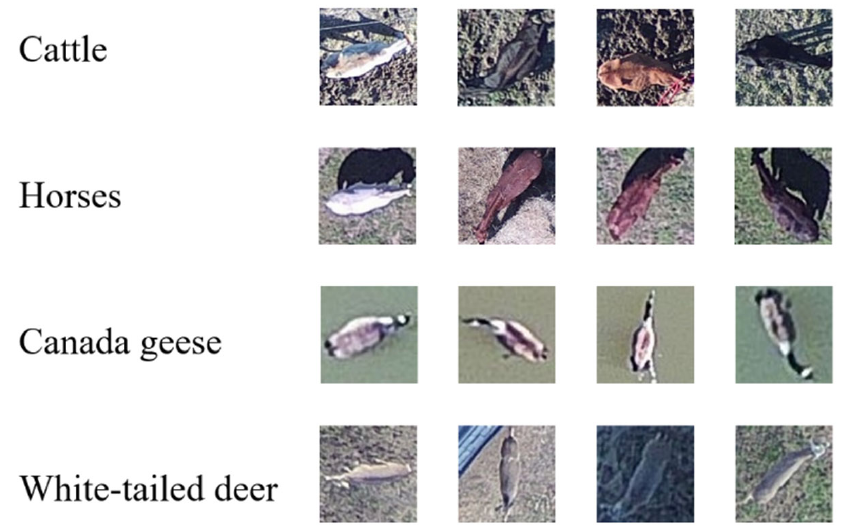
Figure 3. Sample images from dataset used in study.